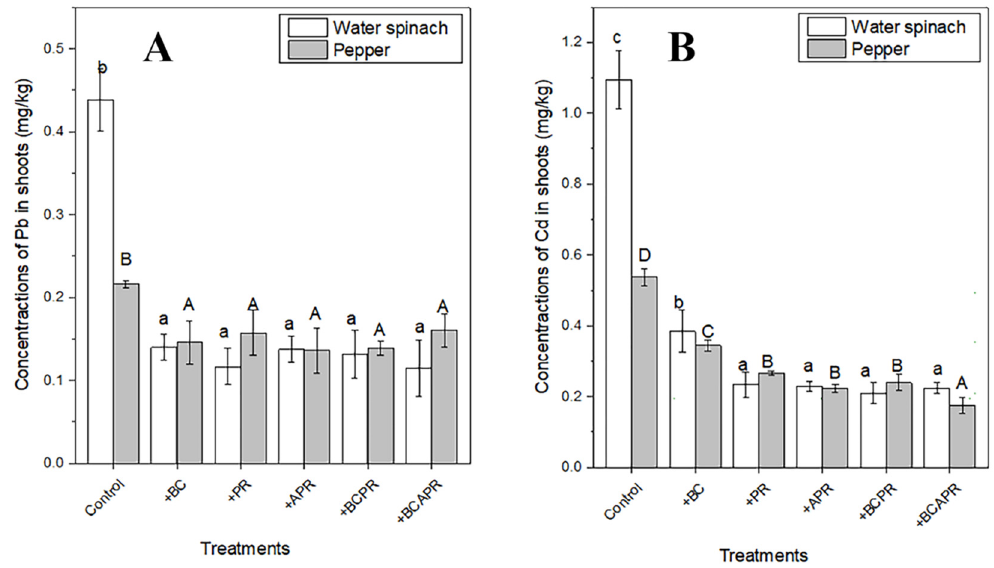
Figure 5. Pb ( A ) and Cd ( B ) uptake by water spinach and pepper in different amendment treatments. The number of replicates was three. Different lowercase letters indicate significant differences in water spinach at p < 0.05. Different capital letters indicate significant differences in pepper at p <